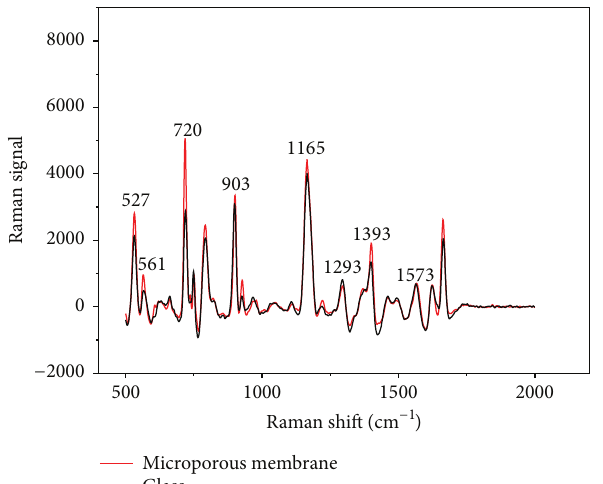
Figure 4: Surface enhanced Raman scattering spectra of 25 𝜇 L crystal violet molecules (1 × 10 −5 M) on the silver nanoparticles coated porous substrate and glass substrate on the fifth day.